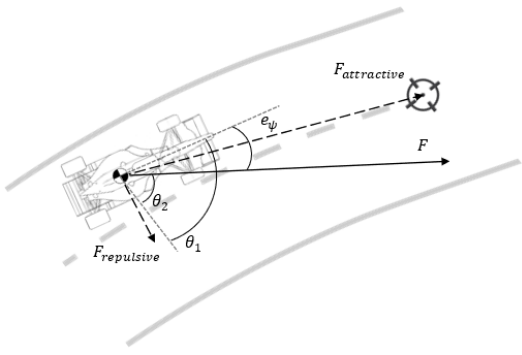
Figure 7. Schematic of the forces felt by the